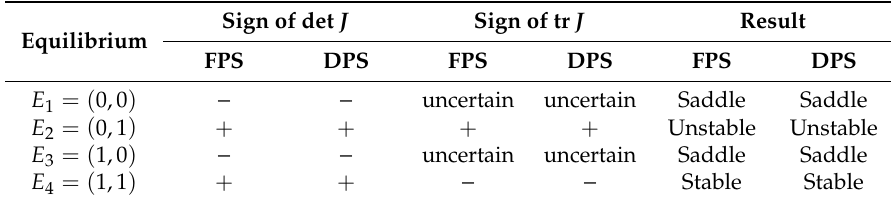
Table 3. Situation 1: local stability of equilibrium.